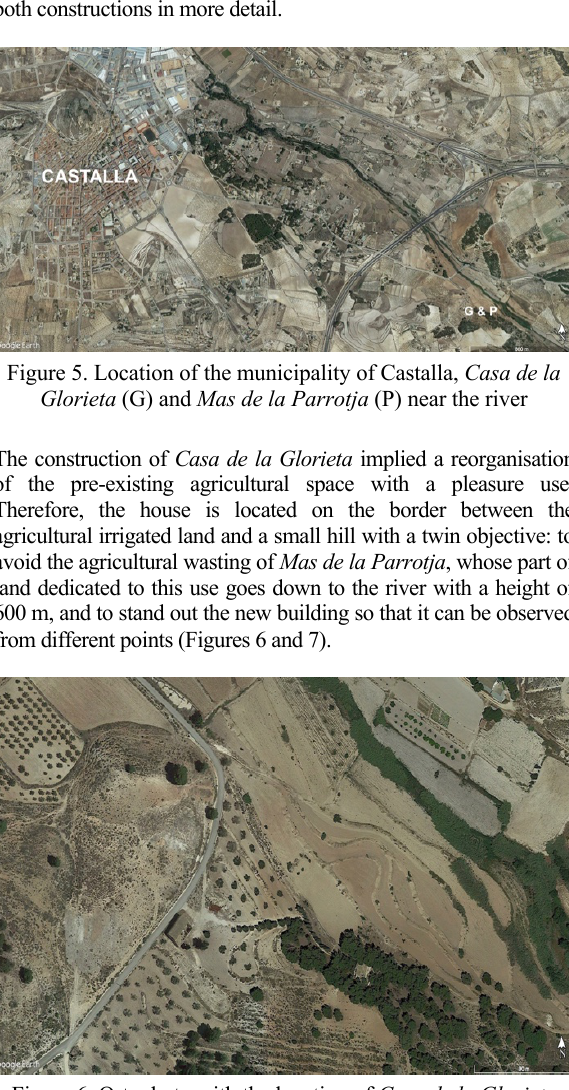
Figure 6. Ortophoto with the location of Casa de la Glorieta and Mas de la